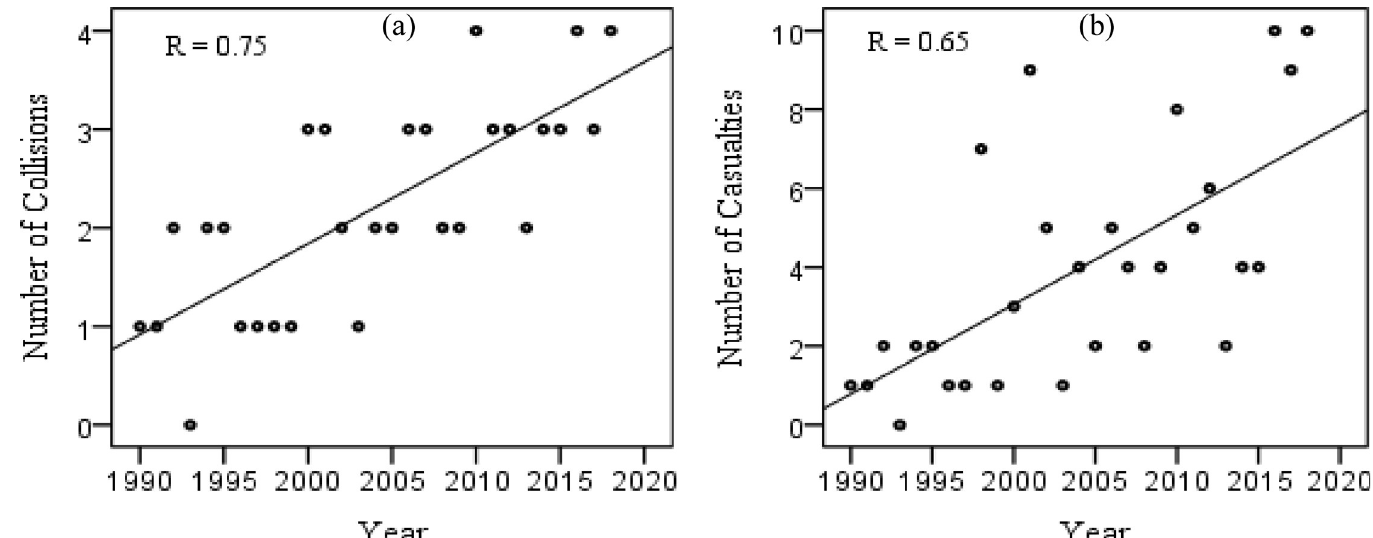
Fig 3. Scatter plots showing increasing trend of (a) elephant-train collisions and (b) casualties over the years.